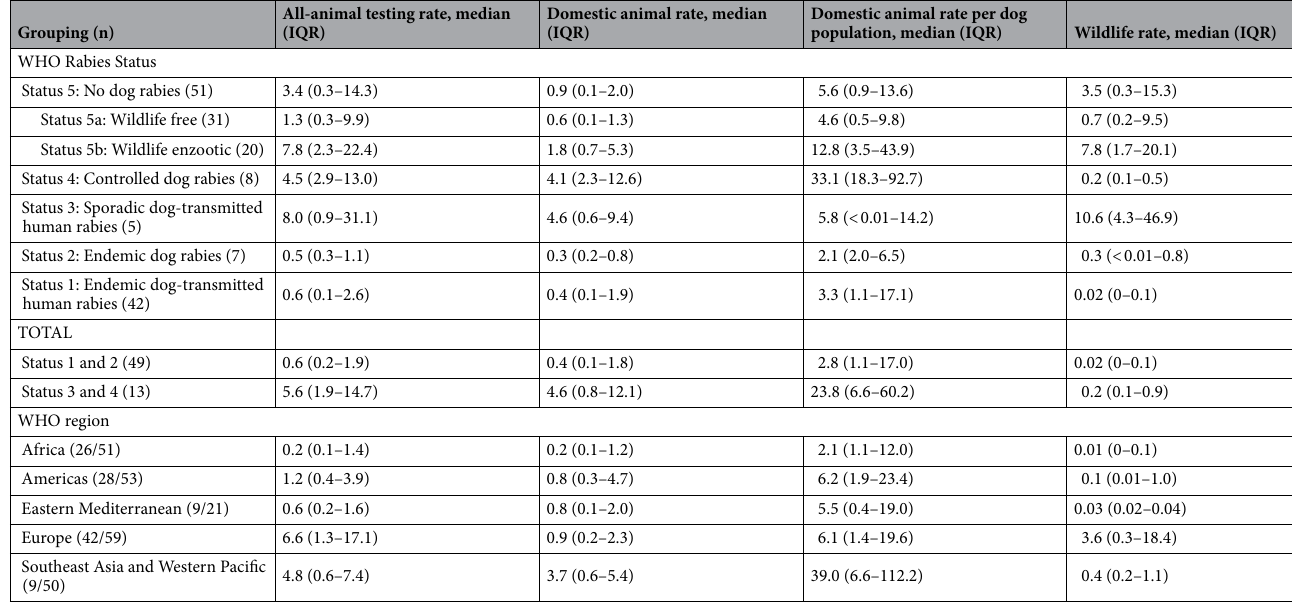
Table 1. Testing rates by WHO Status and region. All rates are per 100,000 population. N’s within each column may differ based on available